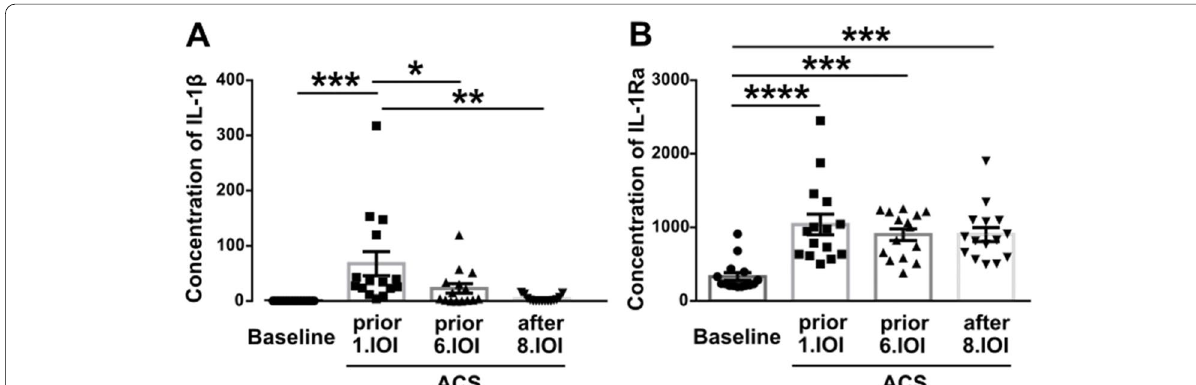
Fig. 1 Concentration of IL-1β (A) and IL-1Ra (B) detected using ELISA in a total of 15 patients. Note that due to low signal intensity in the case of “Baseline” IL-1β, the concentration was set to 0.5 pg/ml. Shown is the mean section. IOI